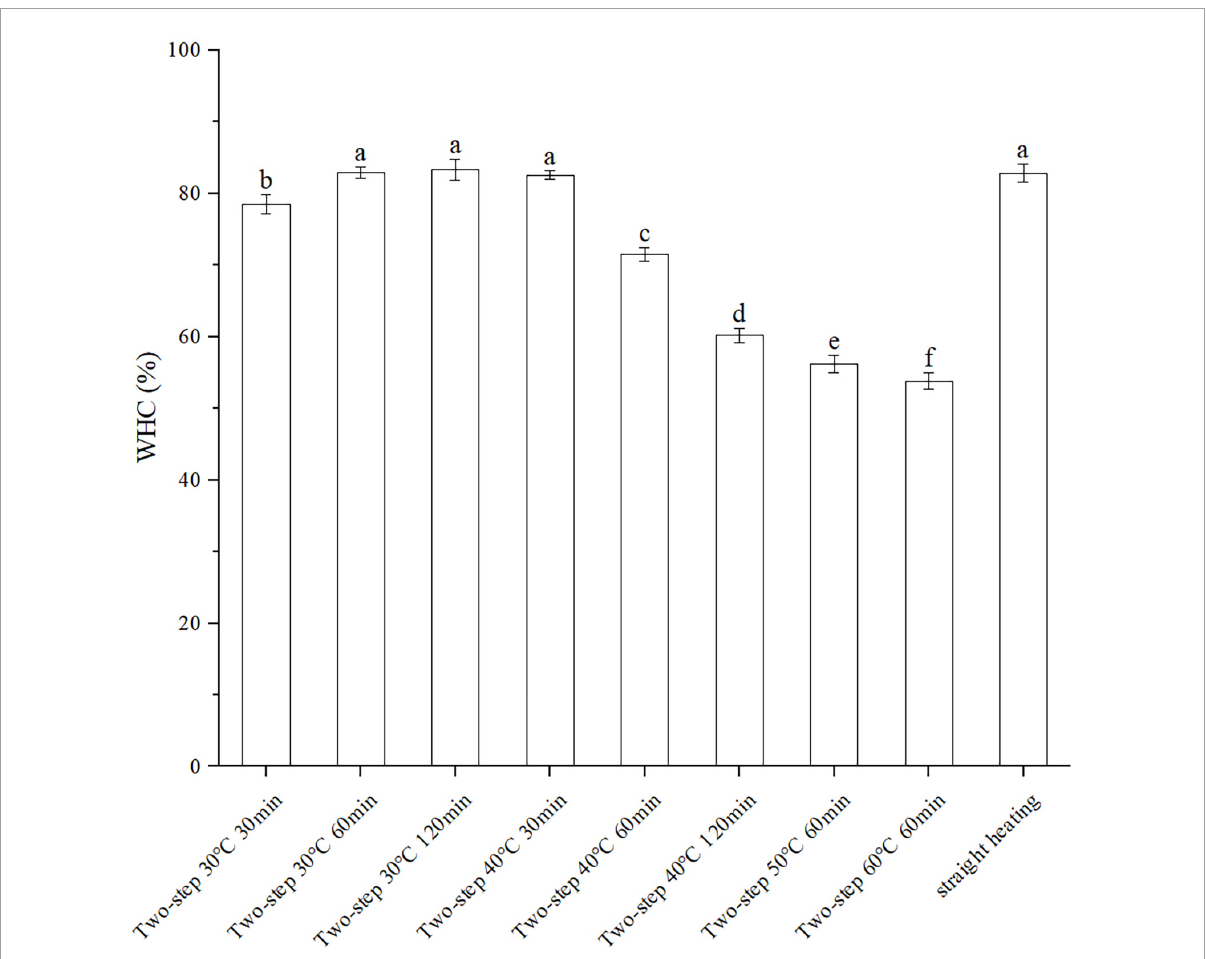
FIGURE2 Changes of WHC under different heating conditions. Different letters showed the significant changes ( p < 0.05). Data were obtained as the mean ± standard deviation ( n =